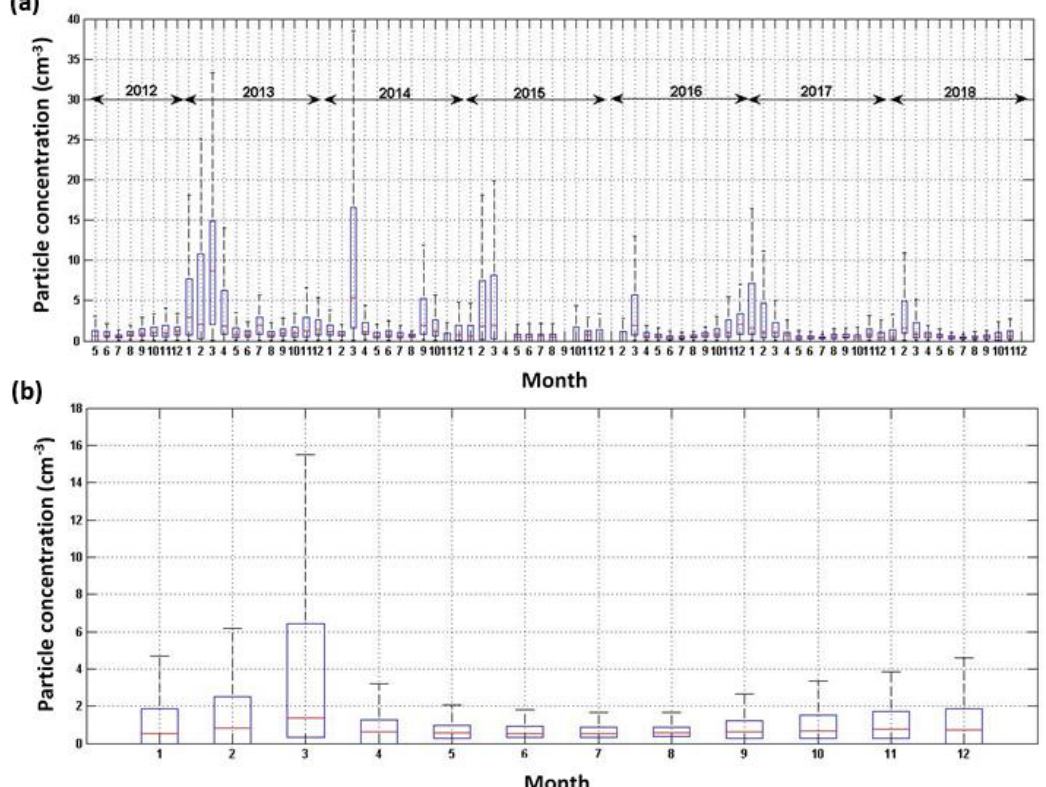
Figure 8. ( a ) Evolution of the total particle concentration (cm − 3 ) of diameter between 540 and 1150 nm measured by the OPC over the entire period; ( b ) seasonal median of this parameter. Red lines represent the median value, bottom and top sides of the boxes symbolize the 25th and 75th percentile, respectively. The length of the whiskers represents 1.5 × interquartile range which includes 99.3% of the